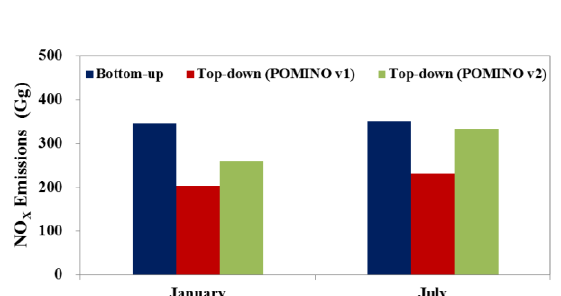
Figure 3. The bottom-up total NO X emission and top-down ones derived from POMINO v2 and POMINO v1 in January and July 2016.